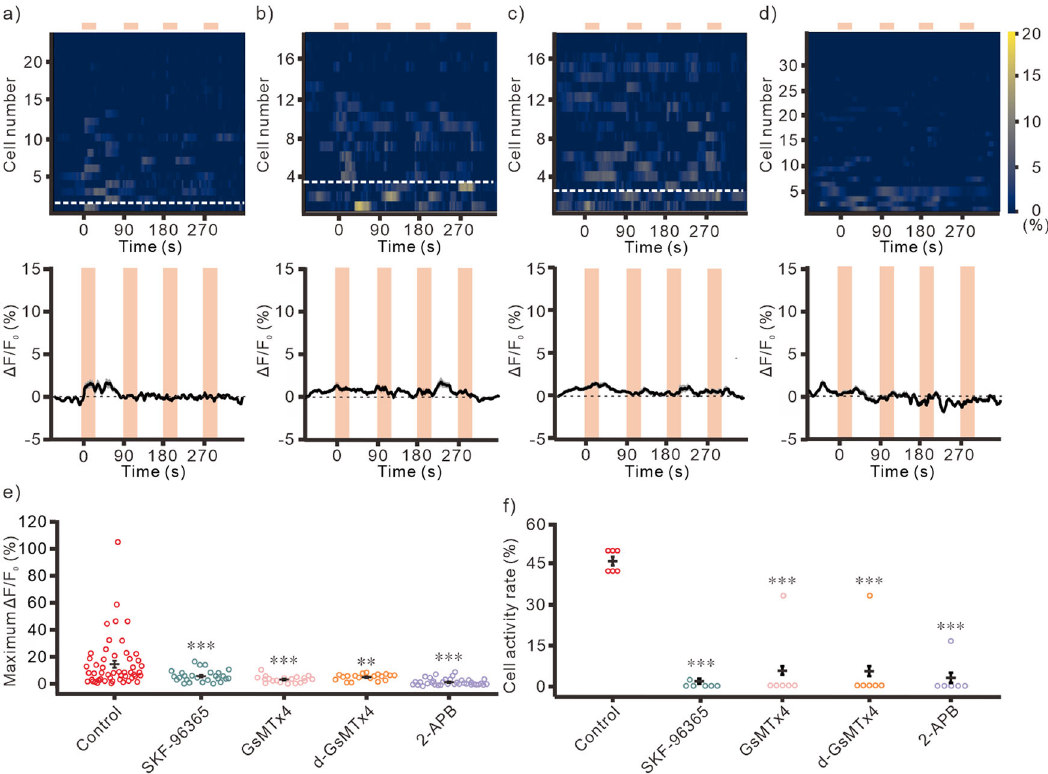
Fig. 4 Reducing the magnetomechanical stimulated responses by different TPRC antagonists. The Ca 2 + responses by multiple magnetomechanical stimulation with bath application of SKF-96365 at 50 μ M ( a , n = 26/6 (neurons/samples)), GsMTx4 at 5 μ M ( b , n = 19/6), d-GsMTx4 at 5 μ M ( c , n = 19/6), and 2-APB at 100 μ M ( d , n = 36/6). The magneticstimulations are 50mTat 10Hz for 30s. Inter-stimulation intervals are 60 s. top, heatmap of individual cells responses. The cells below white dash lines were activated during stimulations. bottom, averaged fl uorescence changes. The light orange areas indicate the time periods of magnetic stimulation. The gray areas are s.e.m. e Maximum fl uorescence changes of MNDs treated neurons with different TRPC blockers at the fi rst magnetic stimulation (Control, n = 52/6 (neurons/samples); SKF-96365, n = 26/6; GsMTx4, n = 19/6; d-GsMTx4, n = 19/6; 2-APB, n = 36/6). F = 146.799, p <0.001, Kruskal-Wallis test. f The cell activity rate of MNDs treated neurons with different TRPC blockers at the fi rst magnetic stimulation (All groups, n = 6). F = 29.017, p <0.001, Kruskal-Wallis test. ** p < 0.01, *** p < 0.001, compared to the control group; Dunn post-hoc test. Error bars represent